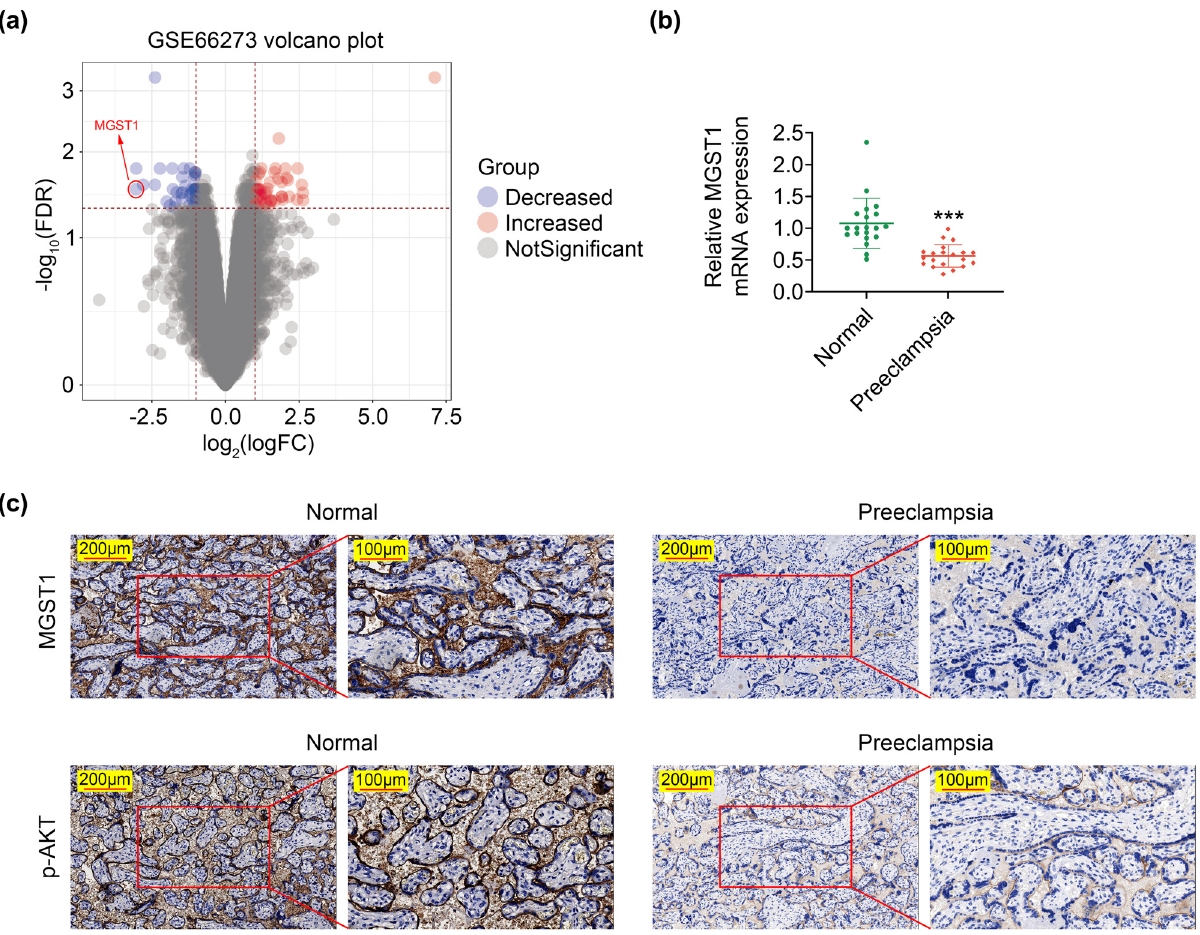
Figure 1: MGST1 was lowly expressed in the placenta of PE patients. ( a ) Volcano plot showed the expression level of MGST1 in the placenta of preterm PE and normal preterm pregnant women using GEO data. ( b ) RT - qPCR was applied to assess the mRNA level of MGST1. ( c ) IHC assay manifested the expression of MGST1 and p - AKT in the placental tissues. *** P < 0.001.